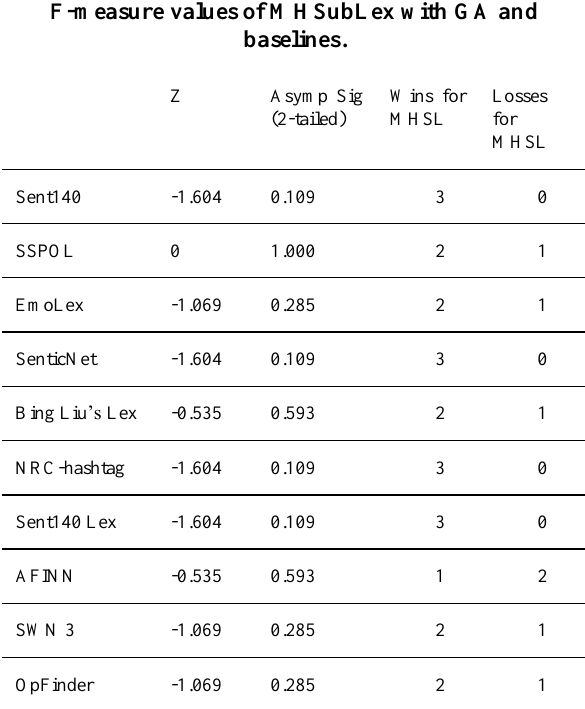
Table 8. Results of Wilcoxon Signed Rank Test for F-measure values of MHSubLex with GA and baselines.